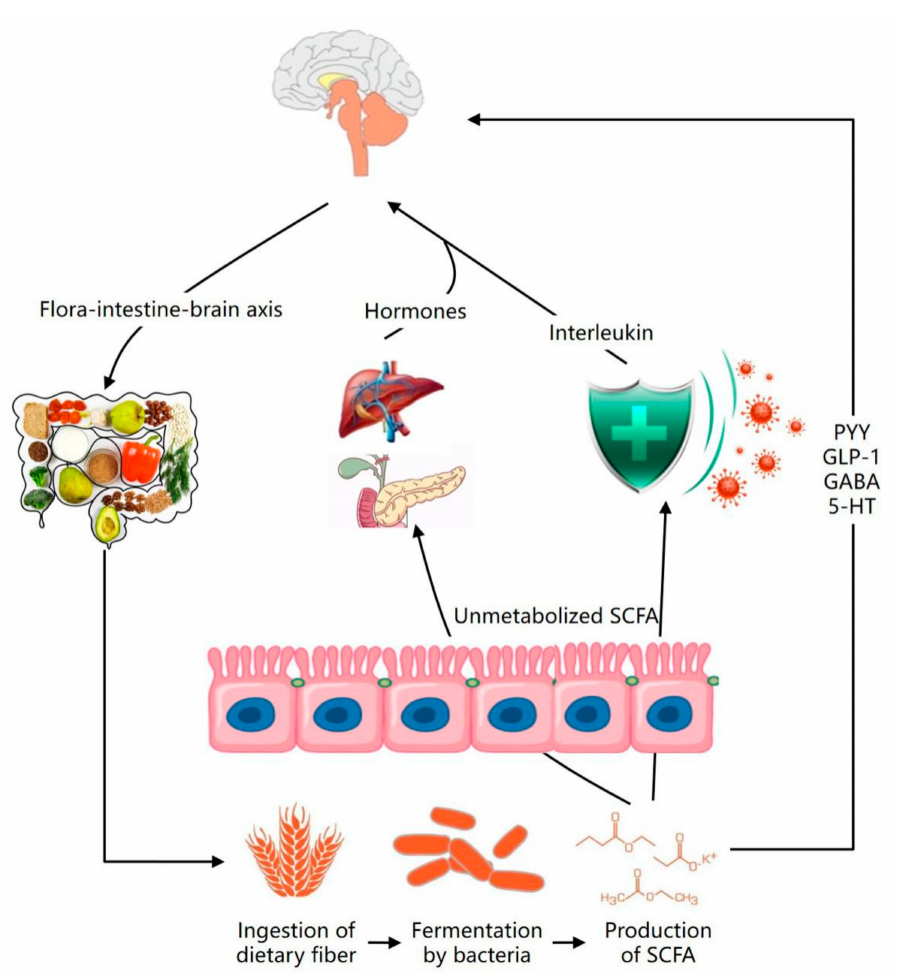
Figure 2. Dietary fiber affects gut microbiota to prevent mental illness. The circulating SCFAs are converted into hormones, 5-HT, GABA, GLP-1, and PYY by the immune system, hepatopancreatic portal system, and adipose tissue, thereby breaking through the blood–brain barrier into the blood– brain border of the central nervous